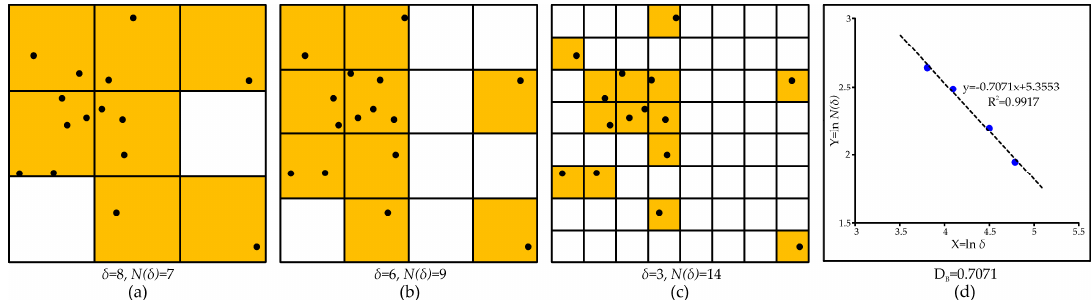
Figure 2. Schematic diagram of box-counting analysis: ( a ) 7 boxes containing target points with box size δ = 8; ( b ) 9 boxes counted with box size δ = 6; ( c ) 14 boxes counted with box size δ = 3; and ( d ) log-log plot revealing the power-law relationship of counted box number N ( δ ) and box size δ , obtaining box-counting fractal dimension D B = 0.7071.